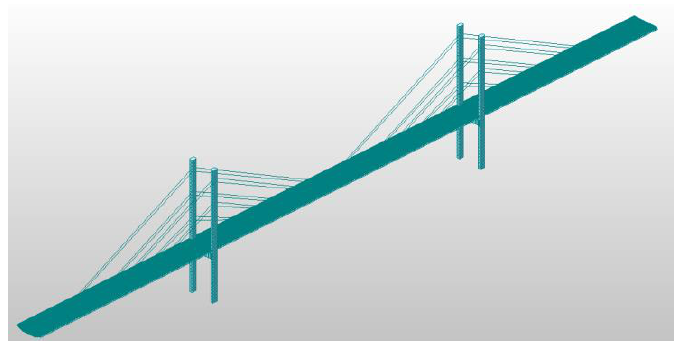
Figure 5. The finite element model of a cable-stayed bridge.